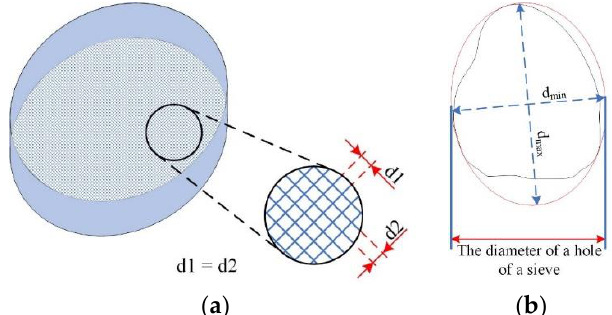
Figure 2. Connection between pellet and the shape that is being approximated: ( a ) area of discrepancy between real area of irregular pellet and circle shaped approximation is marked by the shaded area; ( b ) left side—real area limited by pellet (S1) and perimeter (P1); right side—circle shape formed from the area of pellet.